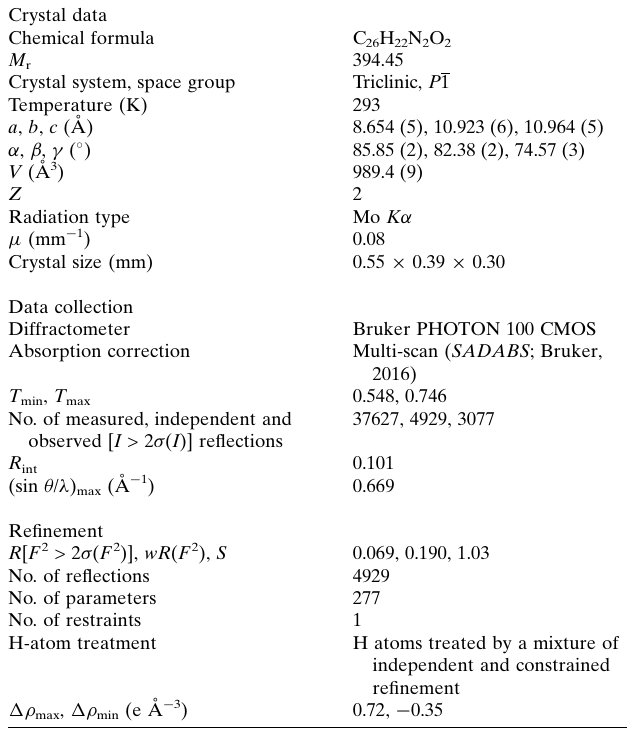
Table 3 Experimental details. Crystal data Chemical